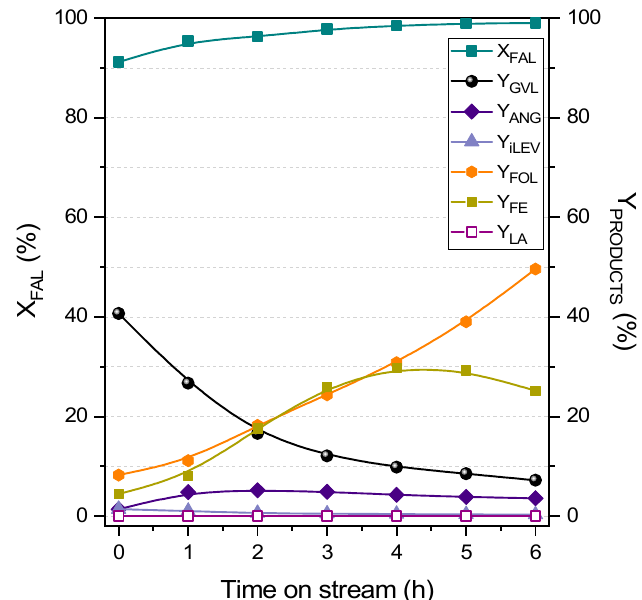
Figure 1. Conversion and product yield profiles in the transformation of furfural versus the time on the stream obtained in the packed-bed reactor charged with the bifunctional Zr–Al-Beta catalyst operating under steady-state conditions. Reaction conditions: temperature = 150 °C; catalyst weight = 0.25 g; FAL concentration = 6 g·L − 1 ; feed flow rate = 0.05 mL·min − 1 ; contact time = 5 min·g·mL − 1 .